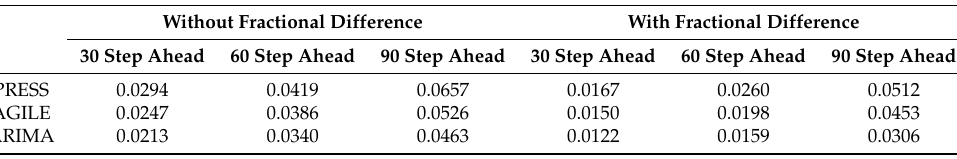
Table 1. RMSE of Prediction on CPU Usage.